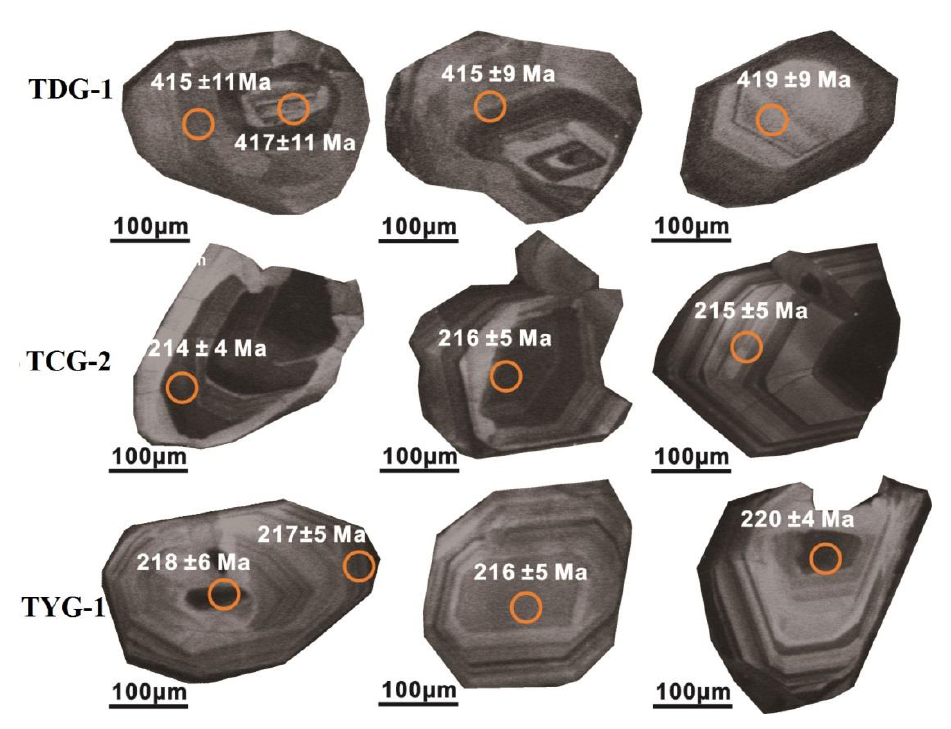
Figure 9. Cathodoluminescence © images of representative zircons grains analyzed from Beidao (TDG-1), Caochuanpu (TCG-2), and Yuanlongzhen (TYG-1) granites. Circles with digits on zircon grains represent Laser Ablation Multicollector Inductively Coupled Plasma Mass Spectrometry (LA-MC-ICPMS) analyses and age values, respectively.